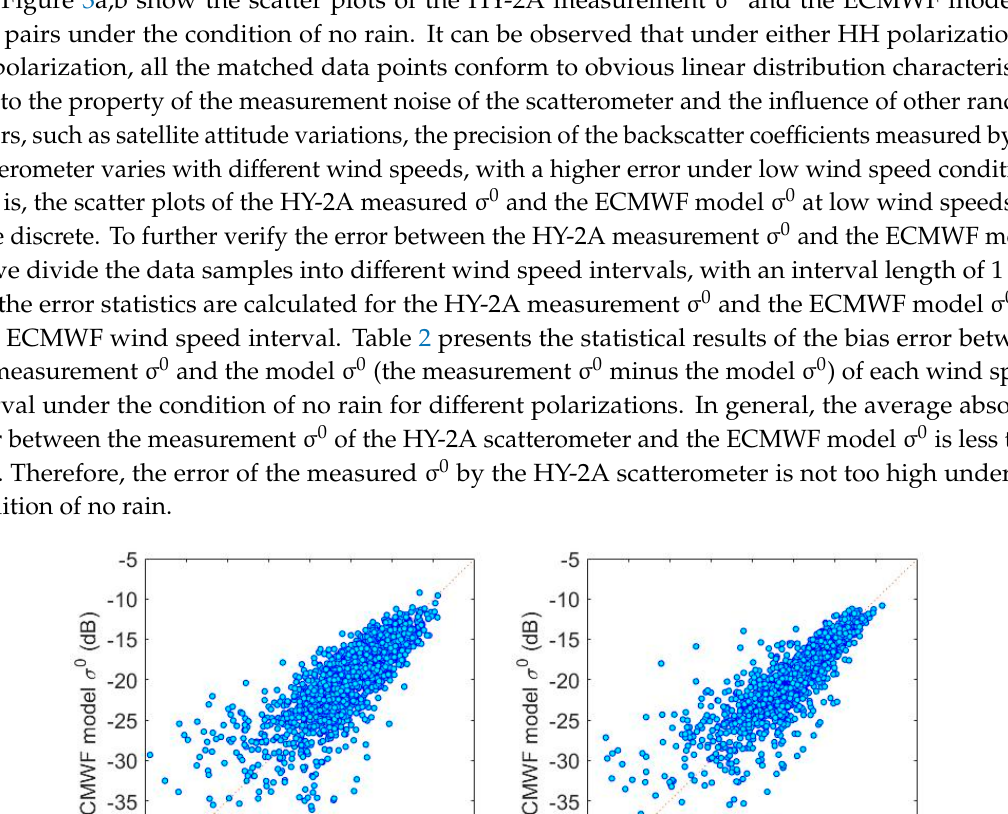
Figure 2. Flow chart of the HY-2A scatterometer neural network rainfall effect correction.